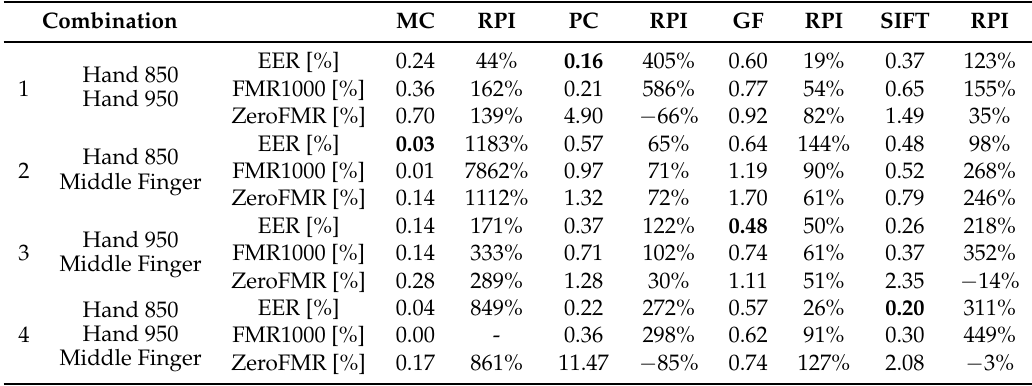
Table 3. Score level fusion recognition performance results and improvement over baseline results. Best EER result (combination 2 for MC, combination 1 for PC, 3 for GF and 4 for SIFT) per feature type is highlighted bold face